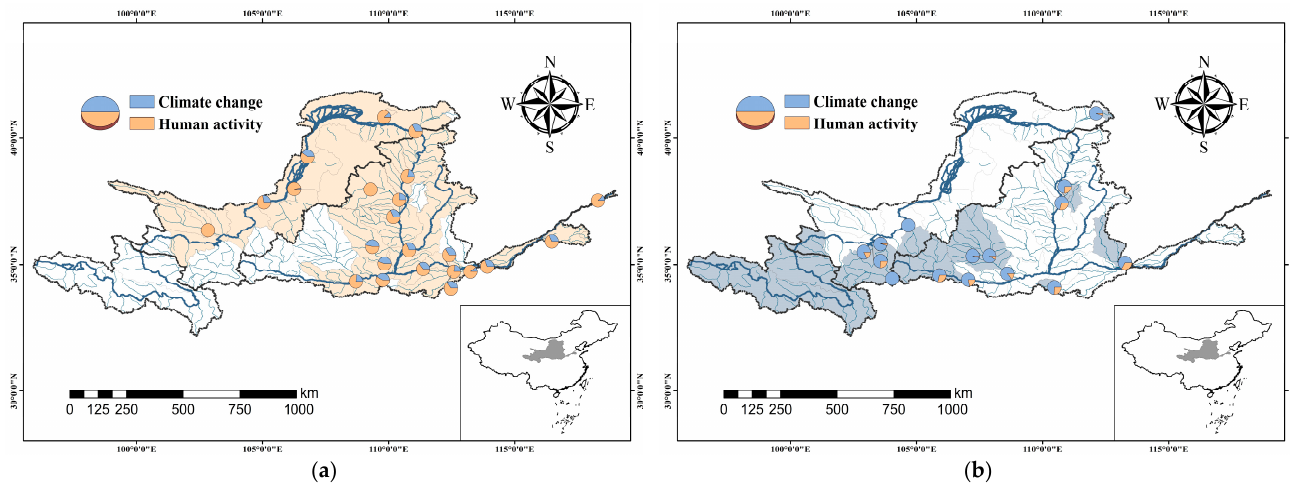
Figure 7. Impacts of human activity ( a ) and climate change ( b ) on runoff changes at major control sections in the Yellow River basin as a percentage.